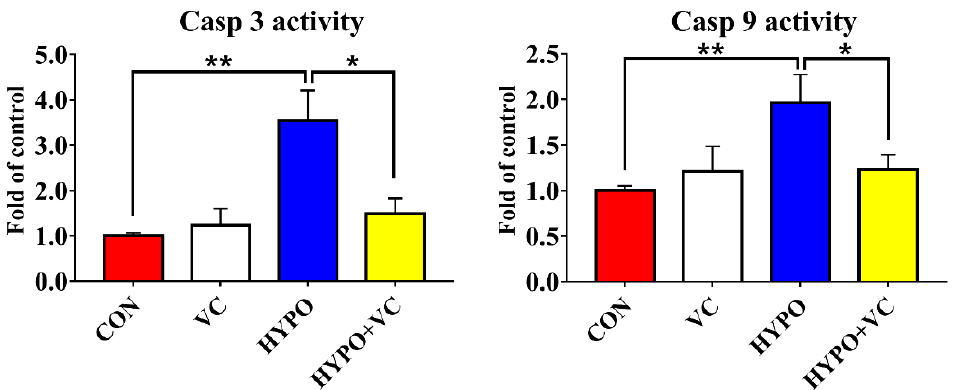
Figure 8. Changes of Casp 3 and Casp 9 activities in the livers of gibel carp in normal group and hypoxia group after 56 days of feeding with VC. The * or ** at the top of the bar chart indicates significant differences between treatments; * indicates a significant difference ( p < 0.05), and ** indicates an extremely significant difference ( p < 0.01). All of the data are presented as the mean ± standard error (n = 6).